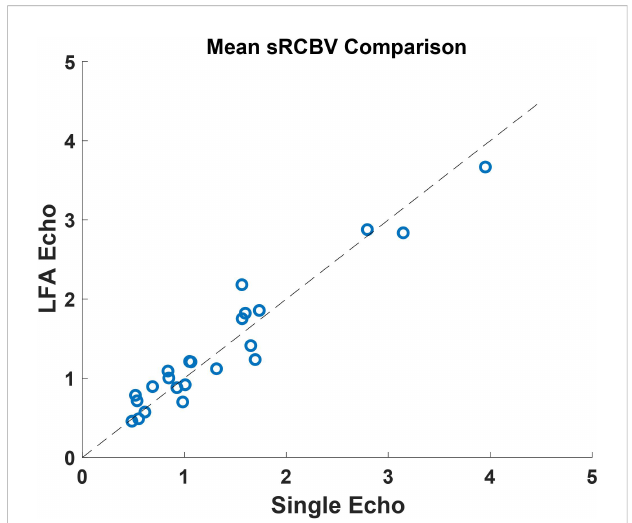
FIGURE 1 A comparison of the mean tumor ROI between the single-dose, dual- echo and the double-dose, single-echo based sRCBV values across all the patients (n=23) included in the study. This shows a strong agreement across the two protocols with a concordance correlation coef fi cient value of 0.96.